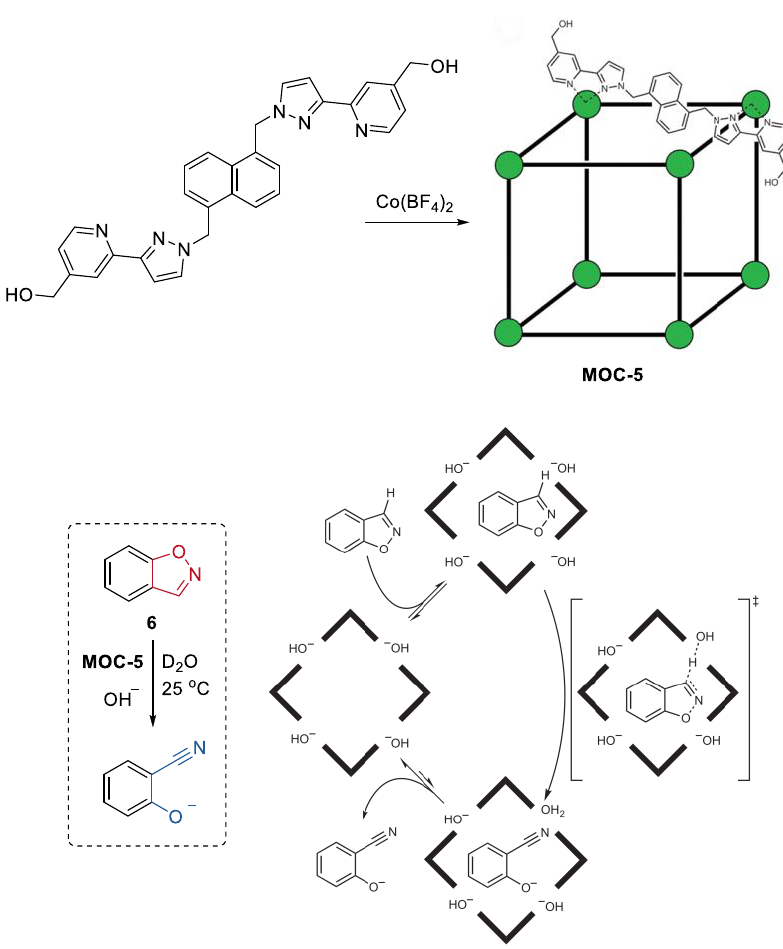
Figure 5. Kemp elimination of benzisoxazole catalyzed by MOC-5 in the presence of base [7]. Reaction additions: 6 (0.85 mM), MOC-5 (1.0 mM), D 2 O, 25 °C. Reprinted/adapted with permission from Ref. [7]. Copyright 2016 Springer Nature Ltd.